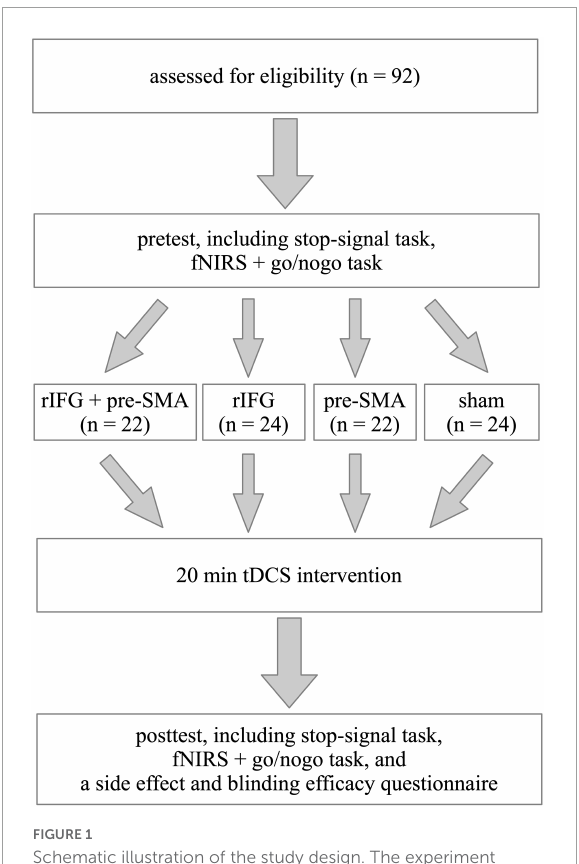
FIGURE1 Schematic illustration of the study design. The experiment followed a single-blinded, randomized, between-subject, sham-controlled, and pretest-posttest design.